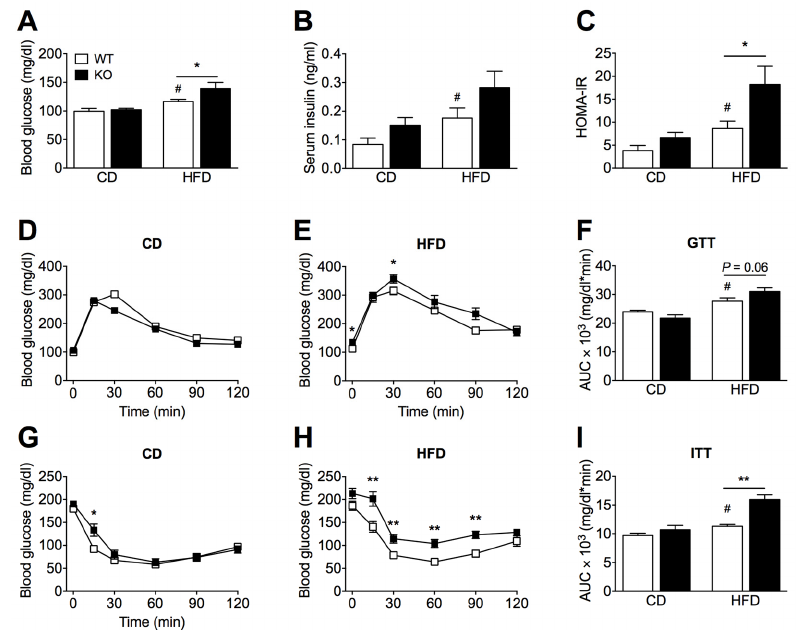
Figure 2. Loss of SIRT2 exacerbates HFD-induced increase in blood glucose levels, glucose intolerance, and insulin resistance. ( A , B ) Blood glucose levels (mg/dL) and serum insulin levels (ng/mL) of WT and SIRT2-KO mice fed a CD or a HFD at the end of the experiment measured after 15 h of fasting. ( C ) Insulin resistance score, HOMA-IR, is calculated as fasting plasma glucose times fasting serum insulin divided by 22.5. ( D , E ) Intraperitoneal glucose tolerance test (ipGTT) was conducted in WT and SIRT2-KO mice after 24 days of CD or HFD feeding. Blood glucose levels of WT and SIRT2-KO mice at different time points after i.p injection of D-glucose (1.5 g glucose/kg body weight). ( F ) Average AUC of the ipGTT curves was calculated using the trapezoidal rule. ( G , H ) Intraperitoneal insulin tolerance test (ipITT) was performed in WT and SIRT2-KO mice fed a CD HFD after 28 days. Blood glucose levels at different time points after i.p injection of human insulin (0.75 U/kg of body weight). ( I ) AUC was calculated using the trapezoidal rule. Data are presented as mean ± SEM; n = 7–8 per group; # p < 0.05 compared with CD-fed WT mice; * p < 0.05, ** p < 0.01 compared with HFD-fed WT mice.